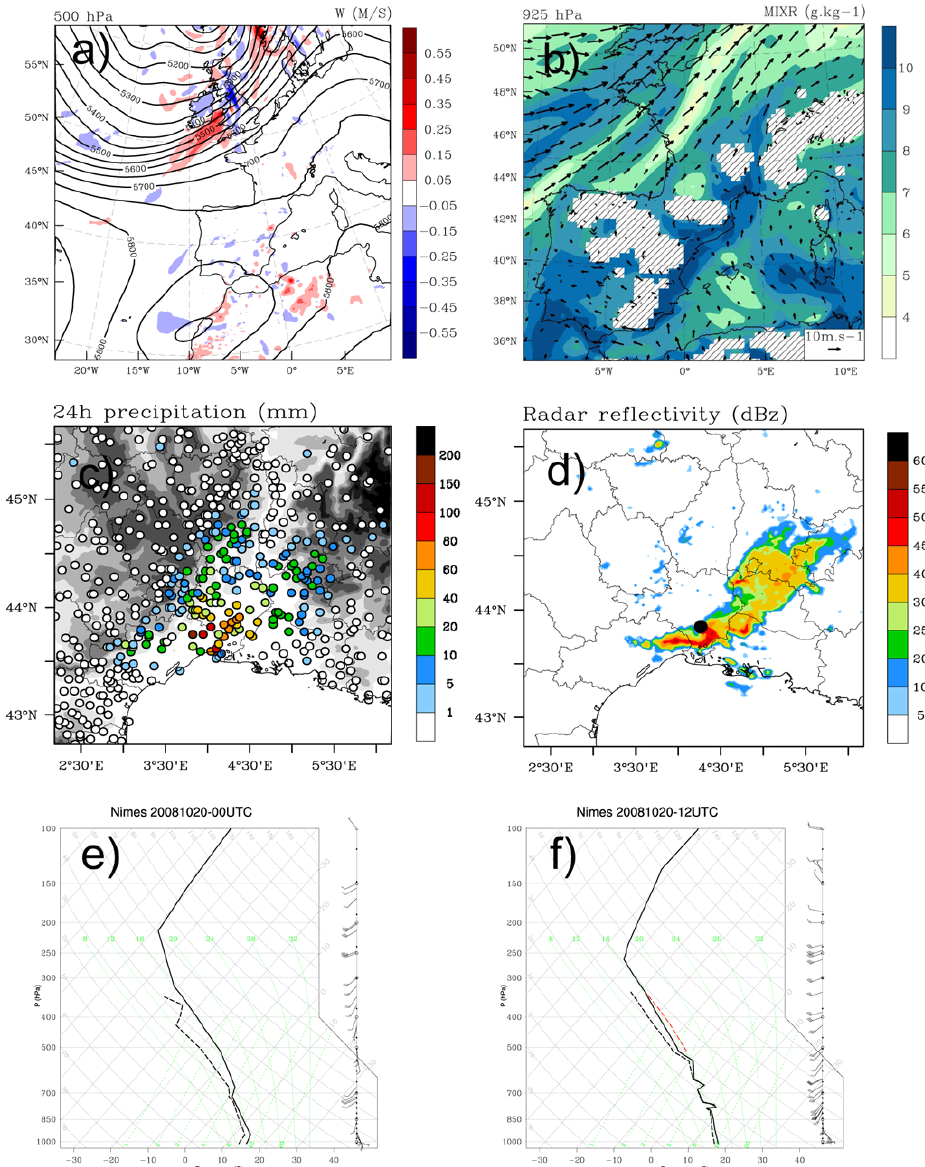
Fig. 2. Overview of the Gard-H´erault case. ECMWF analysis on 12:00UTC, 20 October 2008: (a) 500hPa vertical velocity (ms − 1 ) and geopotential height (in m) and (b) 925hPa water vapour mixing ratio and wind. (c) 24-h accumulated rainfall between 00:00UTC, 20 October and 00:00UTC, 21 October (M´et´eo-France rain gauge network) with relief in shading. (d) Radar reflectivity (dBz) from the Nˆımes radar (location indicated with the black dot) on 20 October 2008 at 15:00UTC. ( e and f ) Nˆımes soundings from 20 Ocober 2008 at 00:00UTC and 12:00UTC,